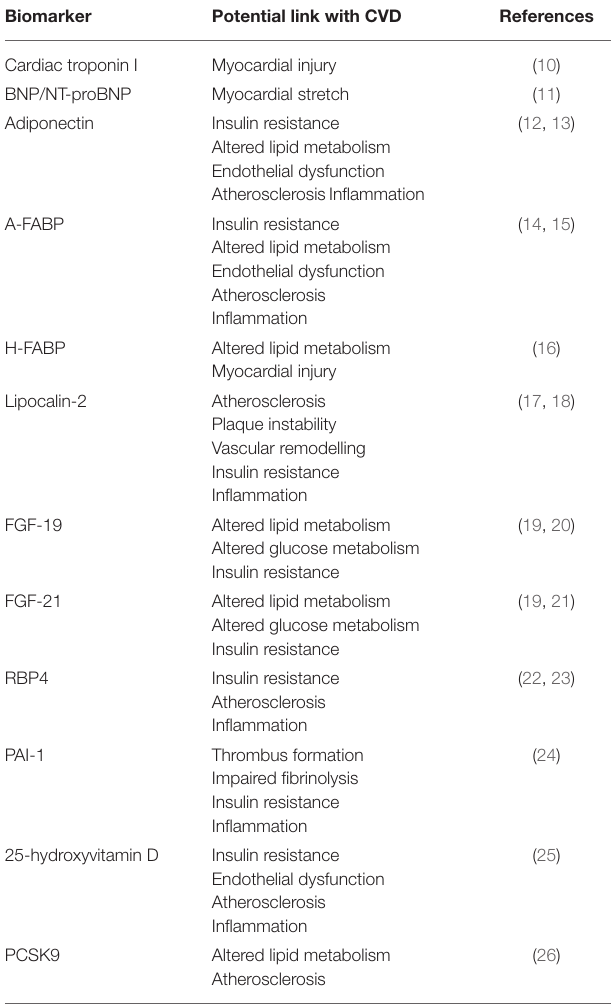
TABLE 1 | Potential mechanistic link between CVD and